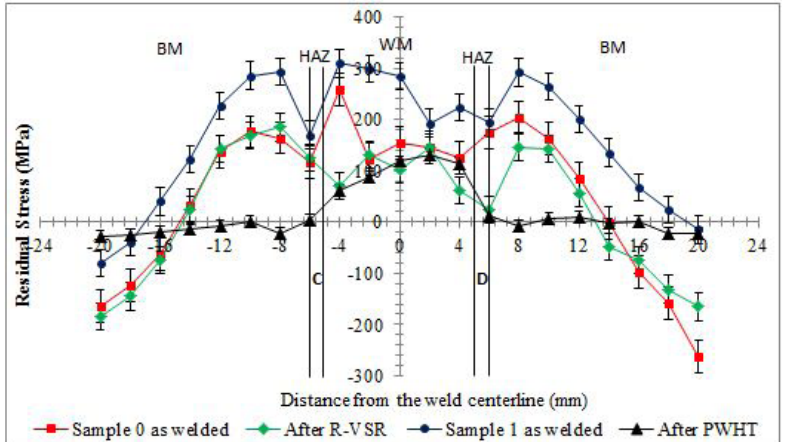
Figure 7. Comparative values of the residual stresses between samples as welded, sample 1 relieved by PWHT and sample 0 relieved by R-VSR. Solid lines indicate the extent of the weld bead and